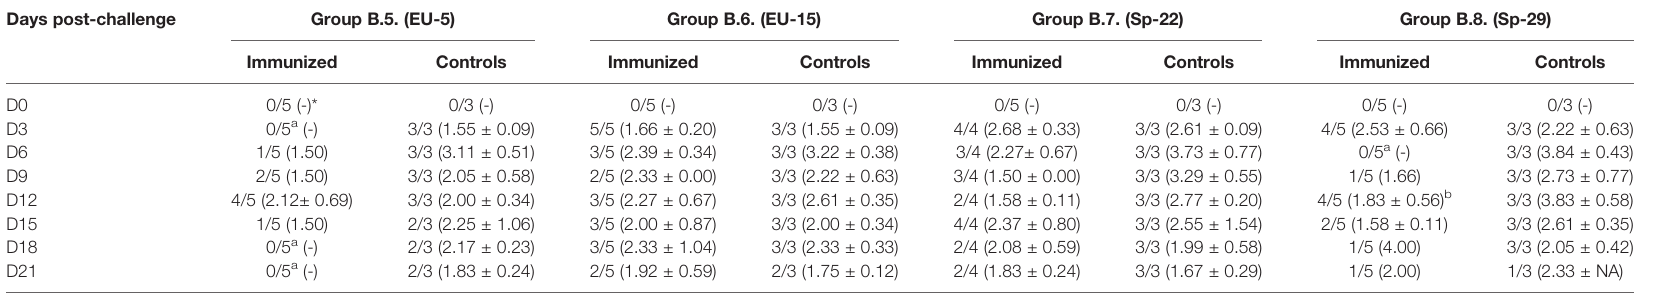
TABLE 4.2 | Virus isolation from serum samples collected in Experiment B (pigs immunized with EU-11a). Days